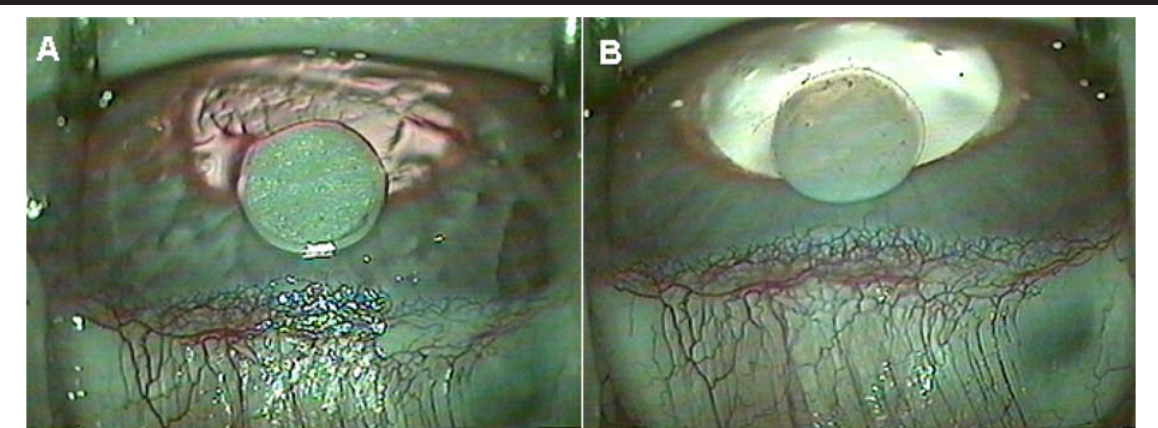
FIGURA 1 - Posicionamento da peça de papel filtro na periferia superior da córnea direita, a aproximadamente 1 mm do limbo (A); aspecto da lesão resultante (B). Magnificação de 16 vezes